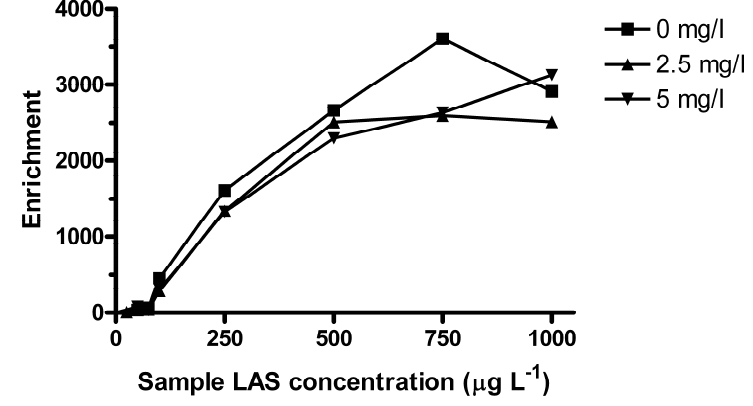
Figure 6. Effect of humic acids, exemplified with C ( n = 3). Conditions as Figure 1, except 100 mL sample extracted during 20 h at 550